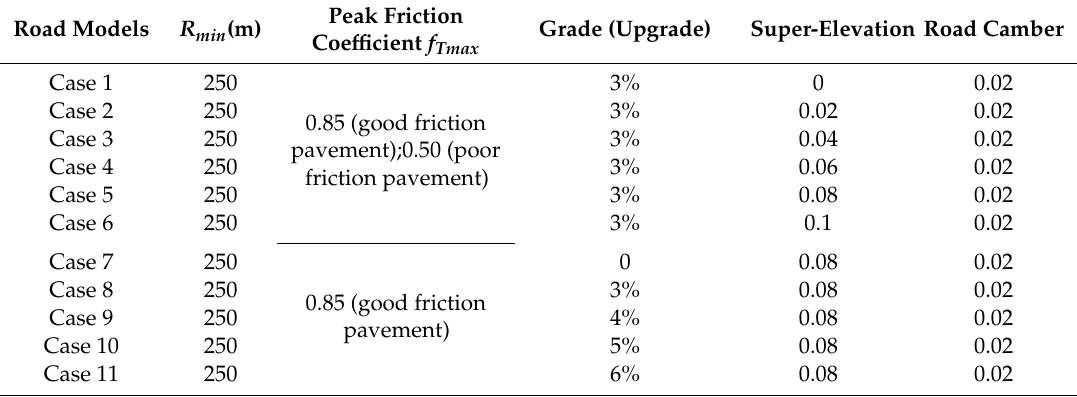
Table 5. Road segments of the Most Unfavorable Road Geometry Combination Curve.